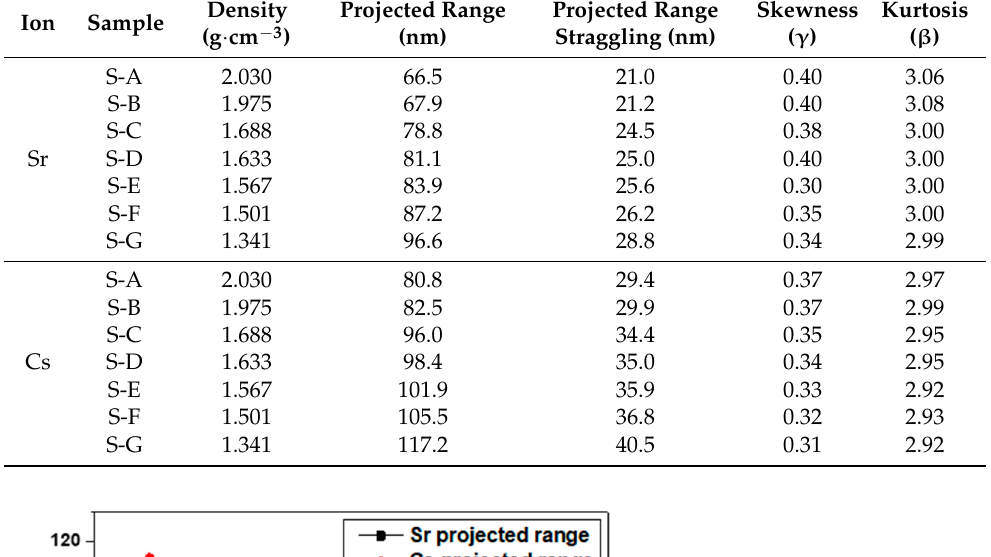
Figure 8. Projected range of Cs and Sr ions as a function of the sample bulk density. Figure 7. Depth profile of ( a ) Cs and ( b ) Sr in different clay samples.